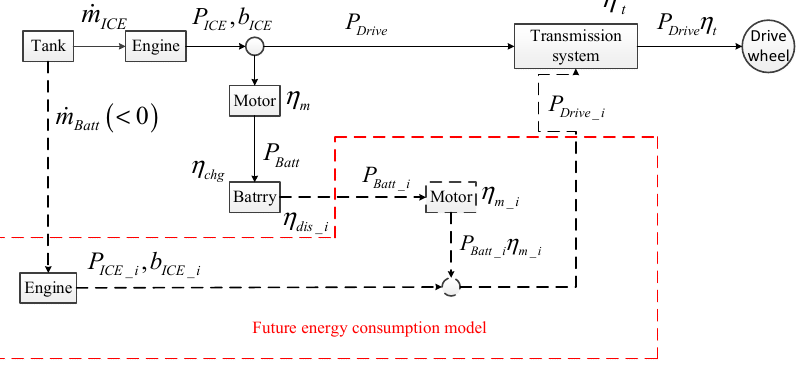
Figure 3. Electric energy future consumption model.